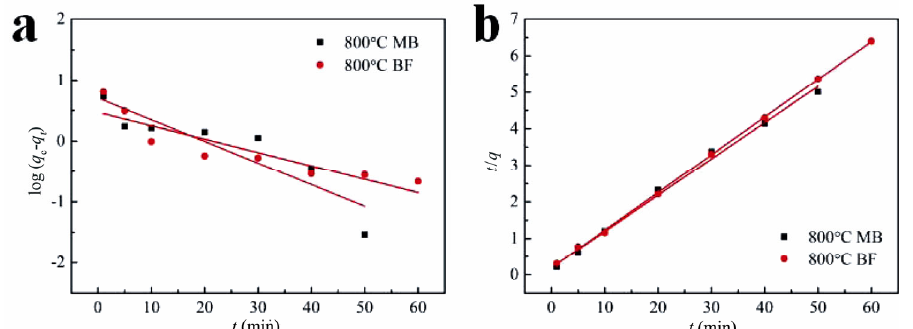
Fig. 11 Kinetic fits for MB and BF adsorption: (a) pseudo-first-order kinetic model, (b) pseudo-second-order kinetic model. Table 3 Kinetics and isotherm parameters for